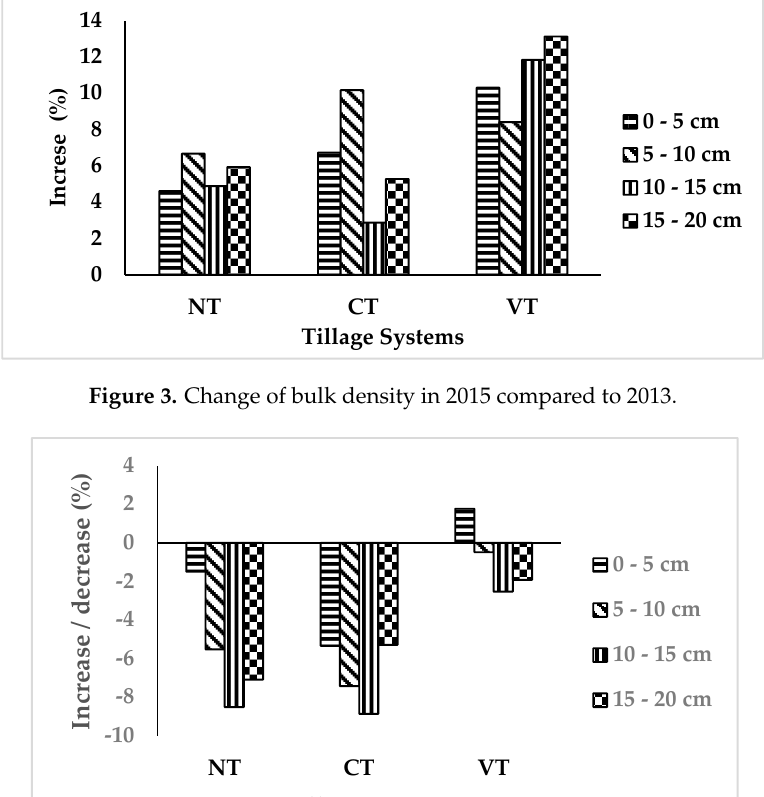
Figure 3. Change of bulk density in 2015 compared to 2013.